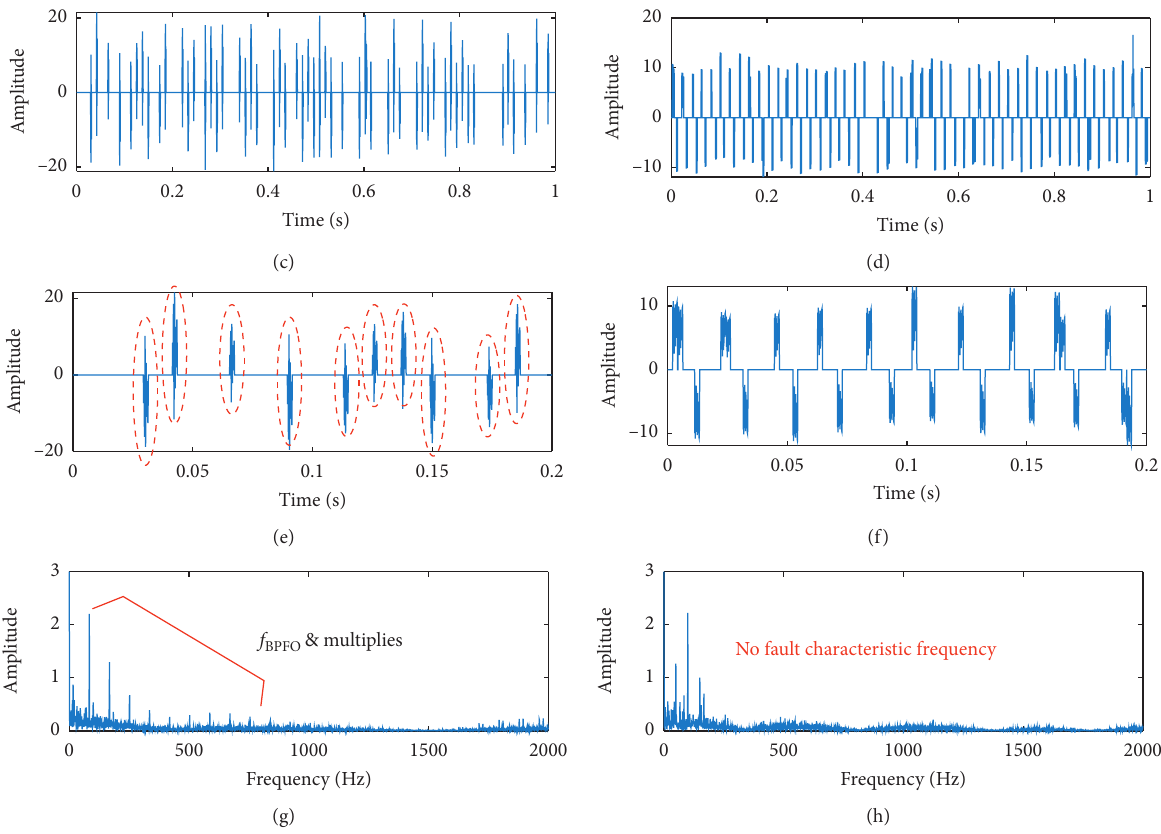
Figure 28: UC-DLA with parameters n � 20 ,k � 34 , L � 2 for identification of wheelset bearing outer race fault. (a) Learned shock response 1; (b) learned shock response 2; (c) sparse reconstruction signal corresponding to shock response 1; (d) sparse reconstruction signal corresponding to shock response 2; (e) locally zoomed figure of the impulses shown in Fig. (c); (f) locally zoomed figure of the impulses shown in Figure 28(d); (g) envelope spectrum of signal in Figure 28(c); and (h) envelope spectrum of signal in Figure 28(d). K = 2.6 @ Level 2.5, Bw = 833.3333Hz, f = 2083.3333Hz max c